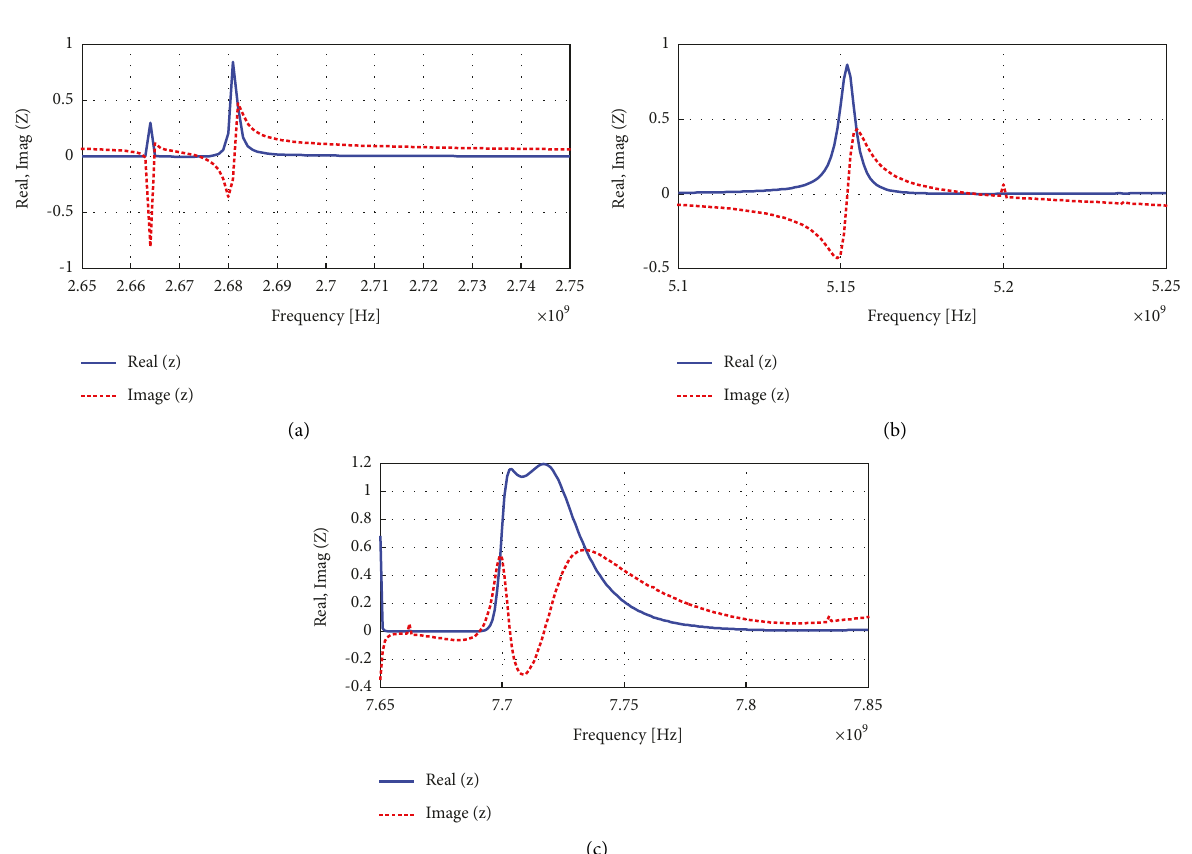
Figure 4: (a) The first resonant frequency of the proposed fractal antenna ( f � 2.68GHz) . (b) The second resonant frequency of the proposed fractal antenna ( f � 5.15GHz). (c) The third resonant frequency of the proposed fractal antenna ( f � 7.72GHz).